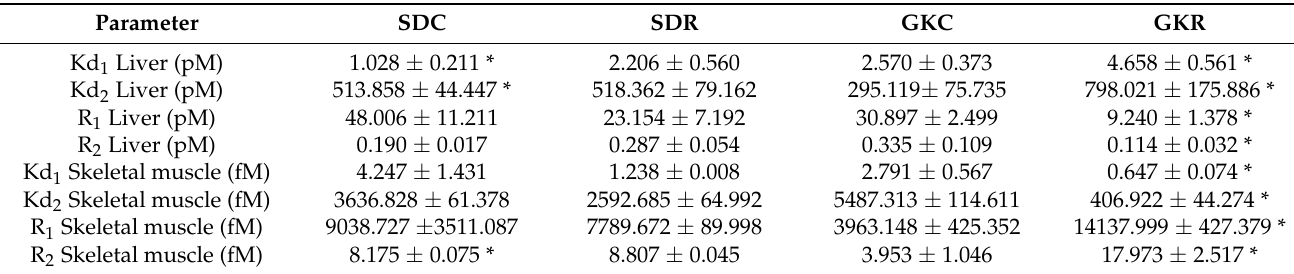
Figure 3. Effects of resveratrol on the expression of insulin receptor and on insulin binding in the liver of SD and GK rats. Expression of insulin receptor ( A ), Western blot immunodetection with antibodies to the indicated proteins, β -actin expression used as a loading control. Protein levels relative to β -actin quantified by densitometry. Results are representative of at least two independent experiments ( B ), Scatchard plot showing insulin binding to the insulin receptor ( C ). Bound— insulin bound to the insulin receptor, Free—free insulin. SDC—Sprague-Dawley control rats, SDR—Sprague-Dawley rats treated with resveratrol, GKC—Goto-Kakizaki control rats, GKR—Goto-Kakizaki rats treated with resveratrol. Results represent the means ± SEM from 10 rats. In the case of studies concerning insulin binding, tissues from 2–3 rats were pooled and results were expressed as the means ± SEM from 4 separate determinations. *—Differences statistically significant ( p < 0.05). Table 2. Effects of resveratrol on parameters related to insulin binding in GK and SD